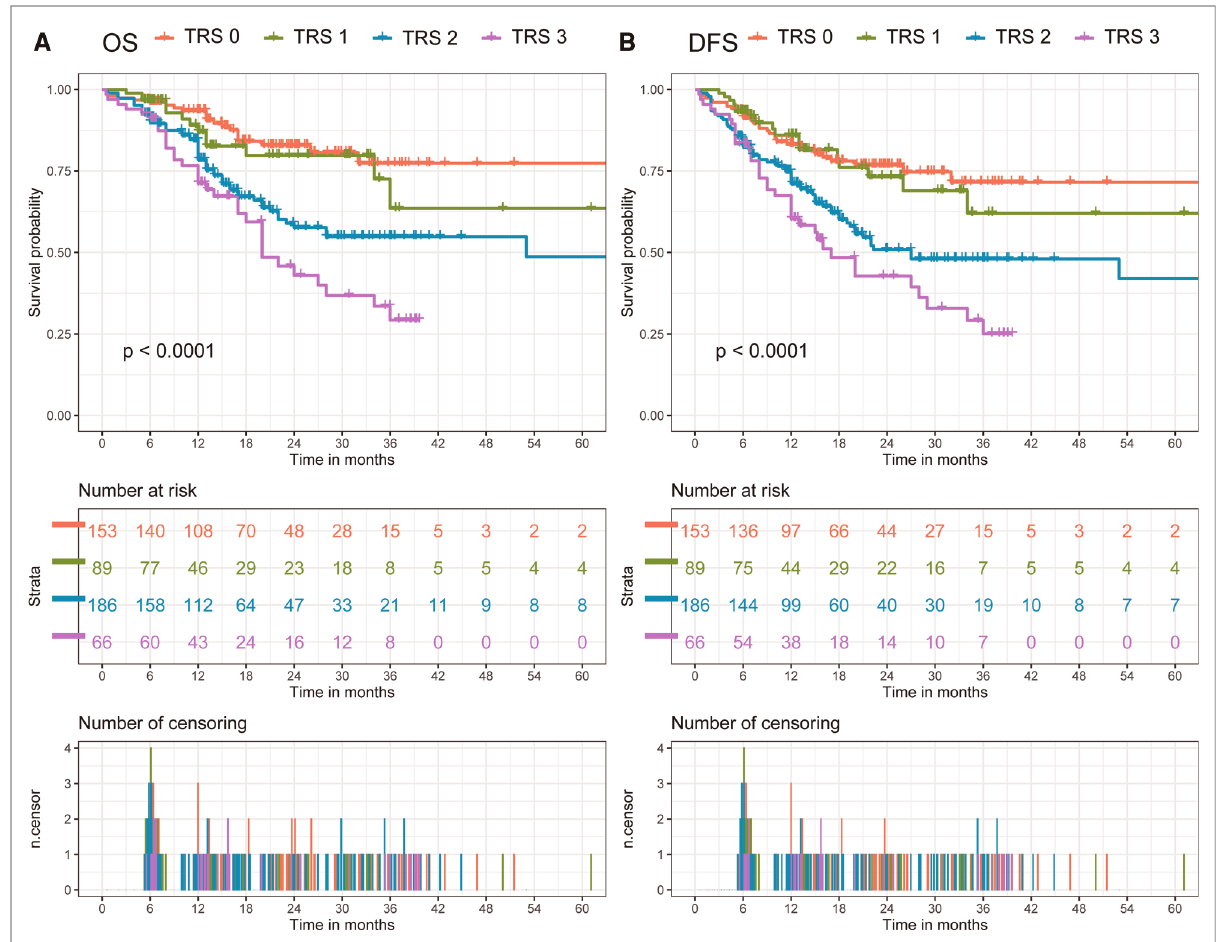
FIGURE 2 Comparison of overall survival (OS) and disease-free survival (DFS) in all cohort. ( A ) Comparison of OS between patients with different tumor regression grade. ( B ) Comparison of DFS between patients with different tumor regression